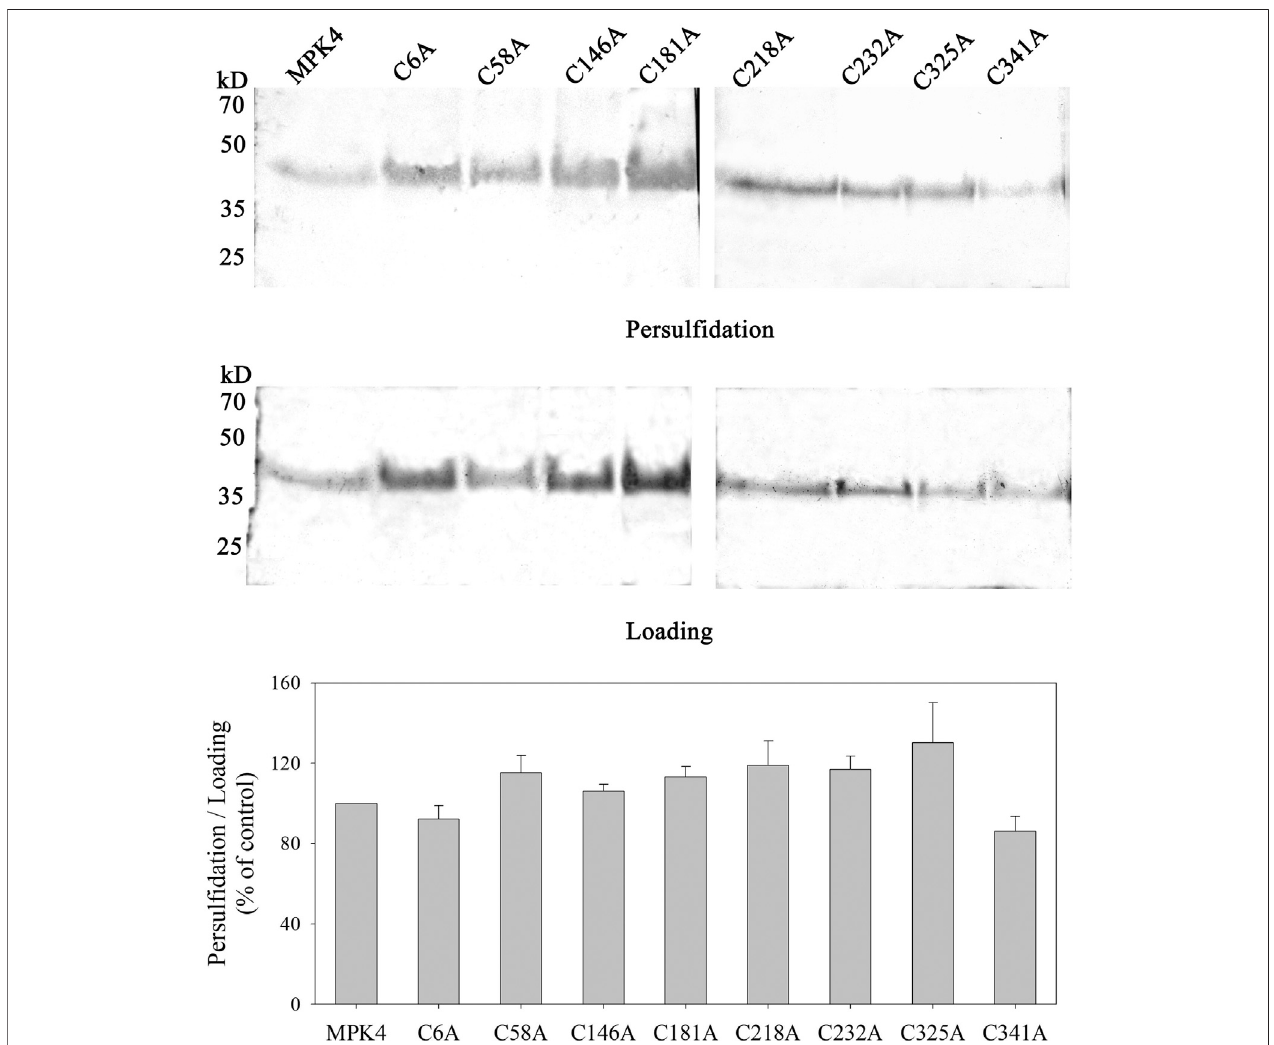
FIGURE 4 | Persul fi dation signal of MPK4 with and without Cys mutation. The eight Cys residues in MPK4 were site-mutated to alanine including cysteine 6, 58, 146, 181, 218, 232, 325 and 341, WT MPK4 protein and site-mutated MPK4 proteins were subjected to biotin-switch assay, in which 10% SDS-PAGE gel and biotin antibody were used. Quanti fi cation anlysis was performed using ImageJ. Data are Mean ± SE, and three independent experiment were repeated. The signi fi cance of difference was analyzed by student ’ t -test. M: Marker.